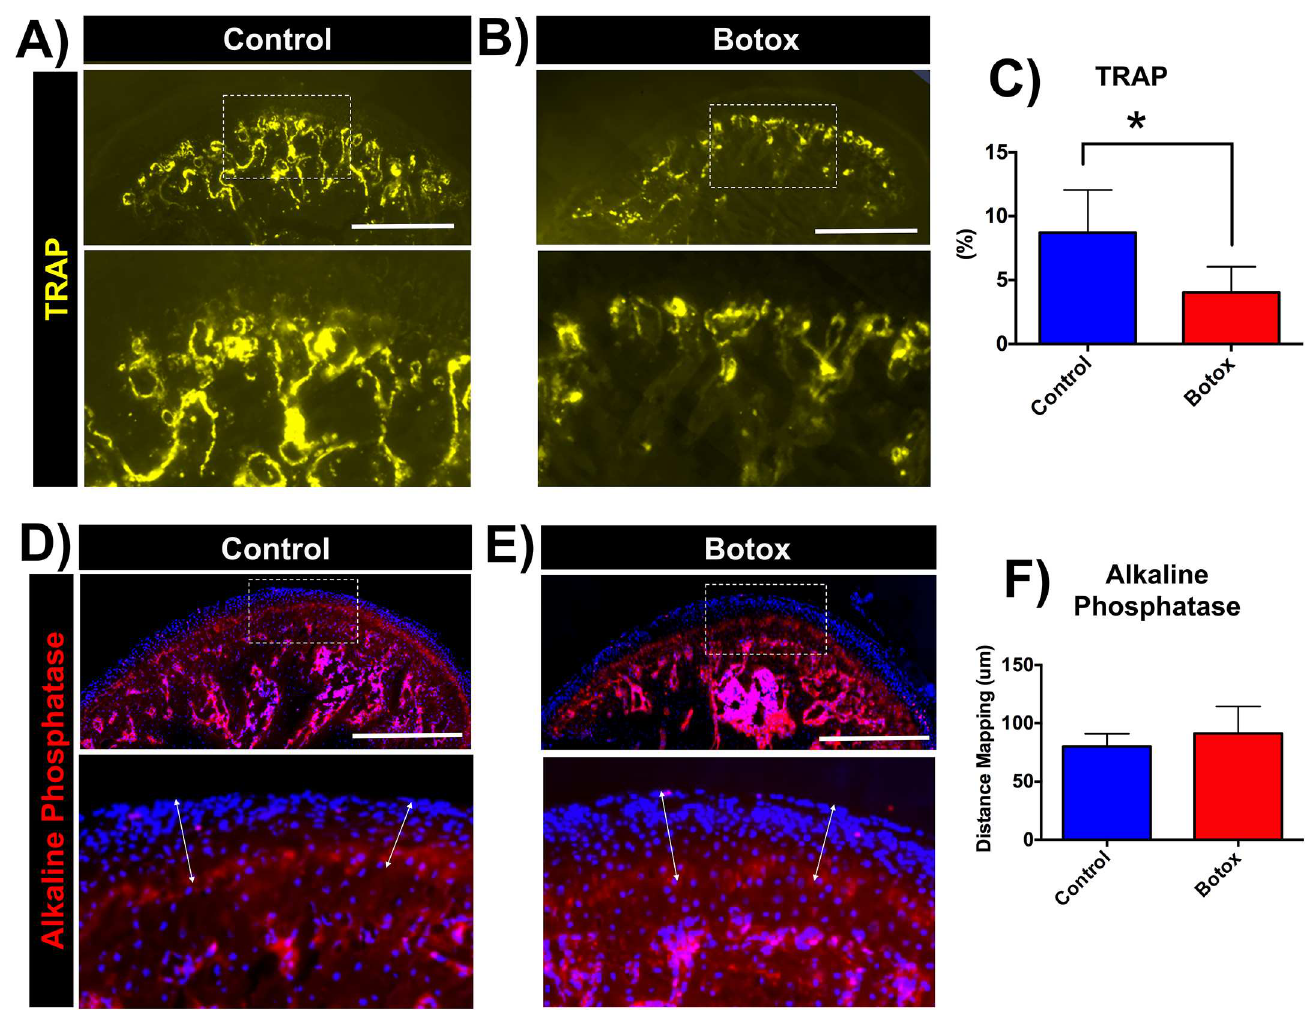
Fig 2. Decreasein osteoclastic activity and mineralization at the Botox injected side condyle. Sagittal sections of control (left side) (A) and Botox (right side) (B) injected side condylesstained for TRAP. C) Quantification of TRAP positive pixels (yellow) over subchondral bone area. Sagittal sections stained for alkaline phosphatase, control (D) and Botox injected side (E) . F) Quantification of distance mapping. Histograms (C,F) represents means ± SD for n = 7 per group . * Significantdifference between control and Botox injected side (p < 0.05). No significant difference between control and Botox injected side for alkalinephosphatase distance mapping (F) . Scale bar = 500 μ